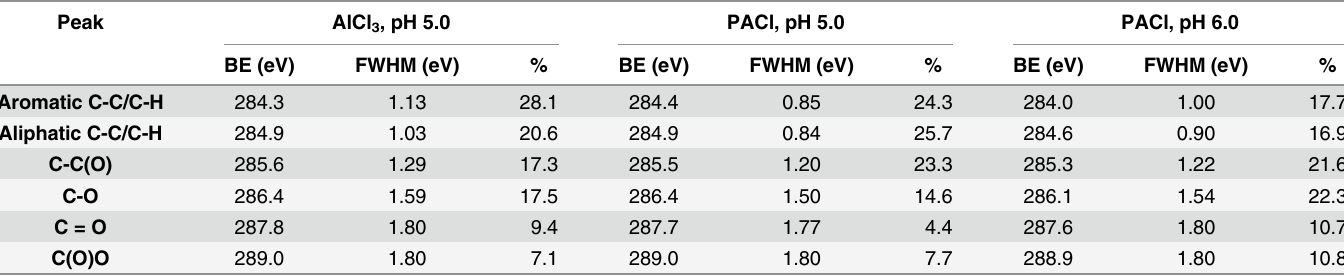
Table 4. Binding energies, full widths at half maximum (FWHM) and percent of total C for different chemical peaks in the C 1s XPS spectra (Fig 7). Peak